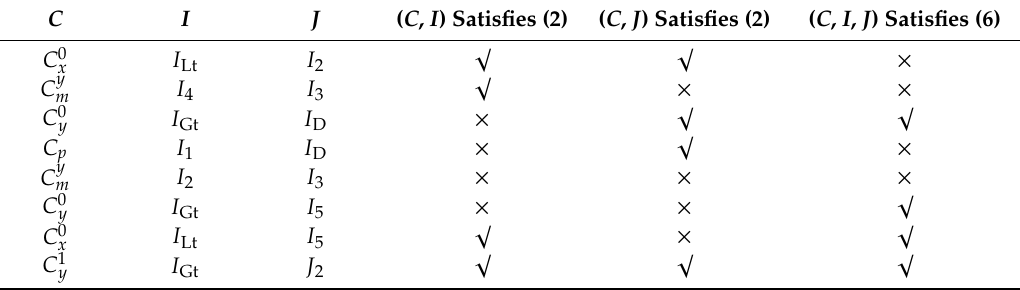
Table 1. The relationships between (2) and